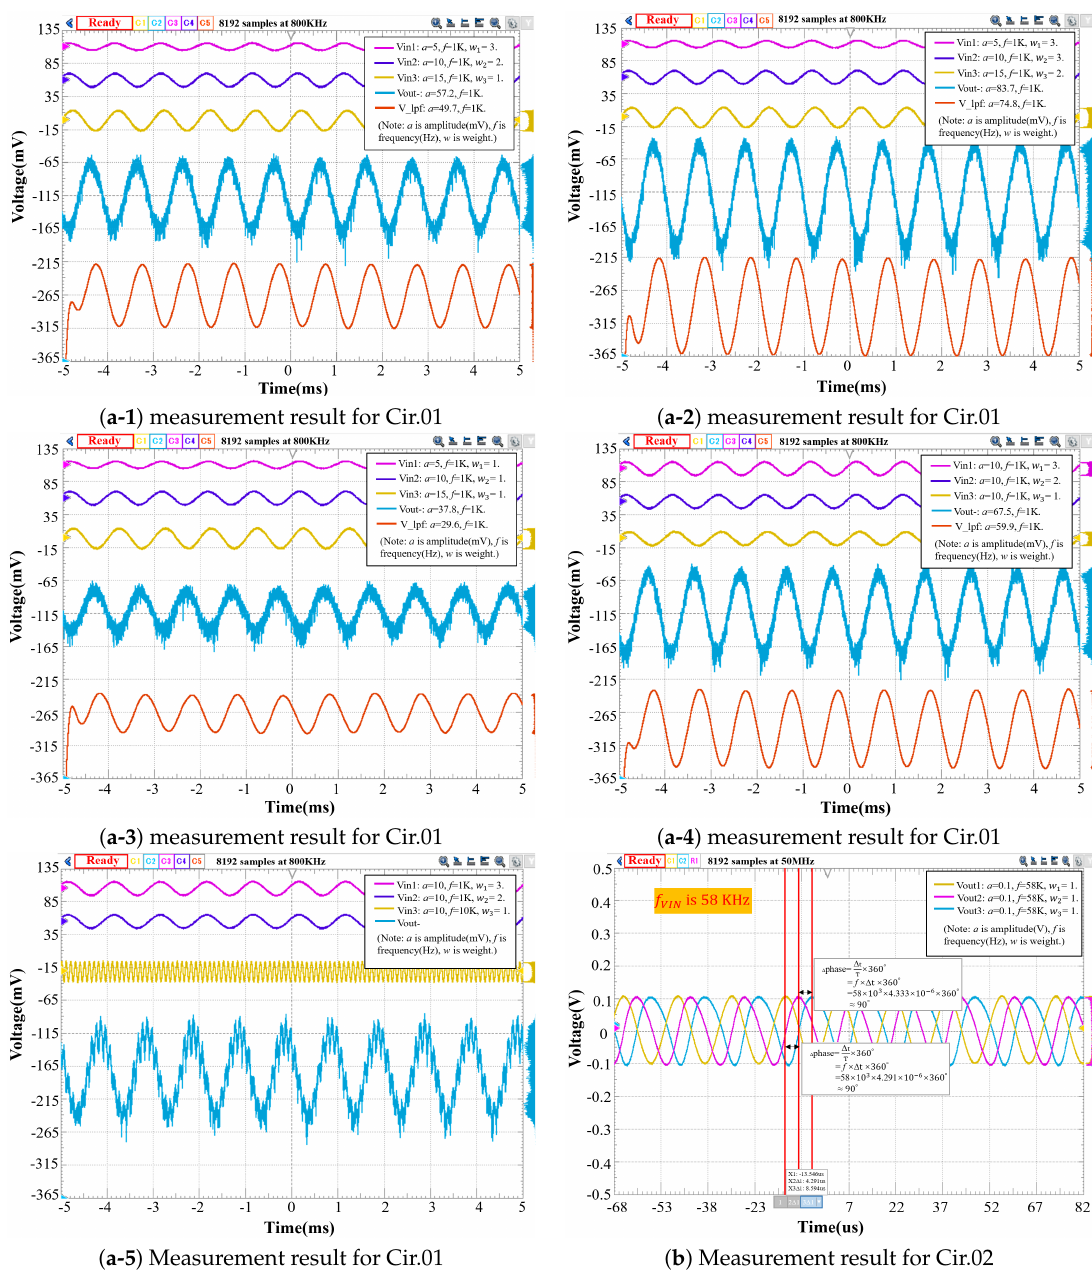
Figure 6. Measurement results for perceptron